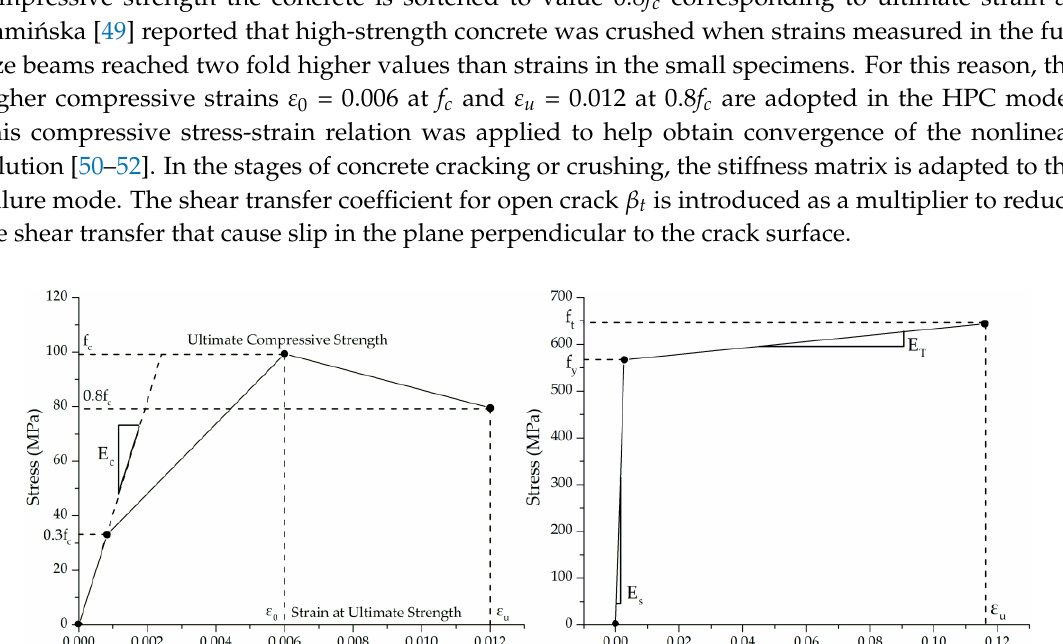
Table 3. Summary of material properties. High Performance Concrete